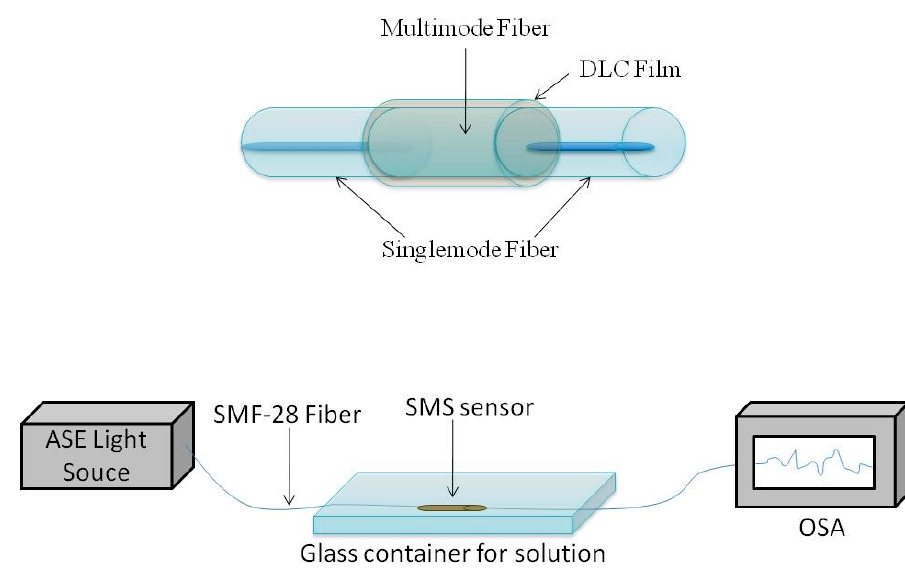
Figure 1. Schematics of a coated SMS sensor and experimental setup for refractive index